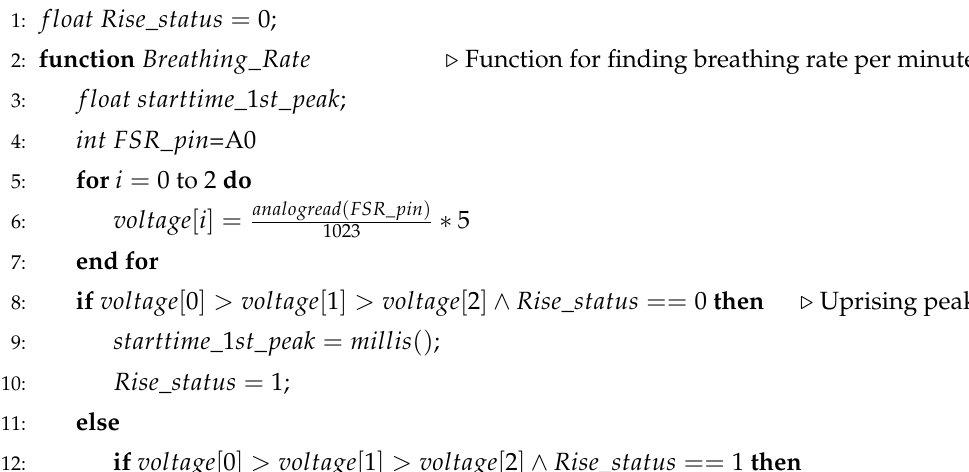
Algorithm 1 Measuring breathing rate per